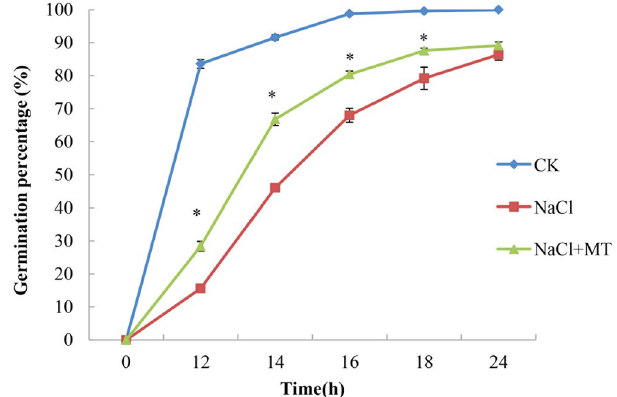
Figure 1. Melatonin promotes seed germination under high salinity. Melatonin (1 μ M) promotes seed germination under NaCl stress. Vertical bars represent ± S.E (n = 3). * Significant difference between different treatments at P < 0.05 based on Duncan’s multiple range